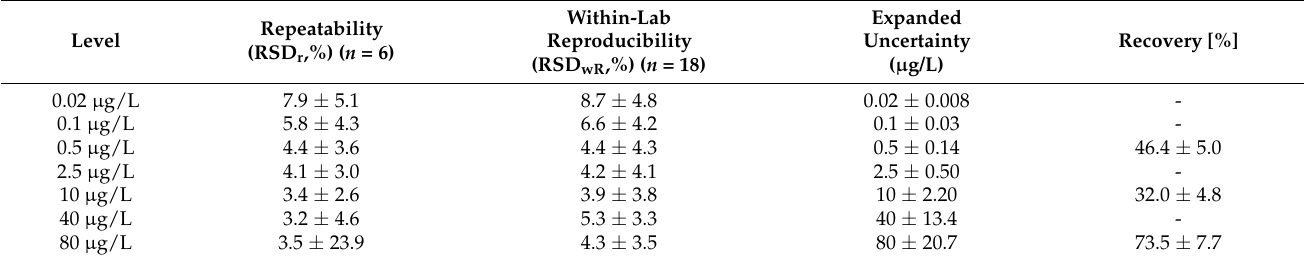
Table 3. Parameters obtained for the calibration curves during validation of lipemic plasma.